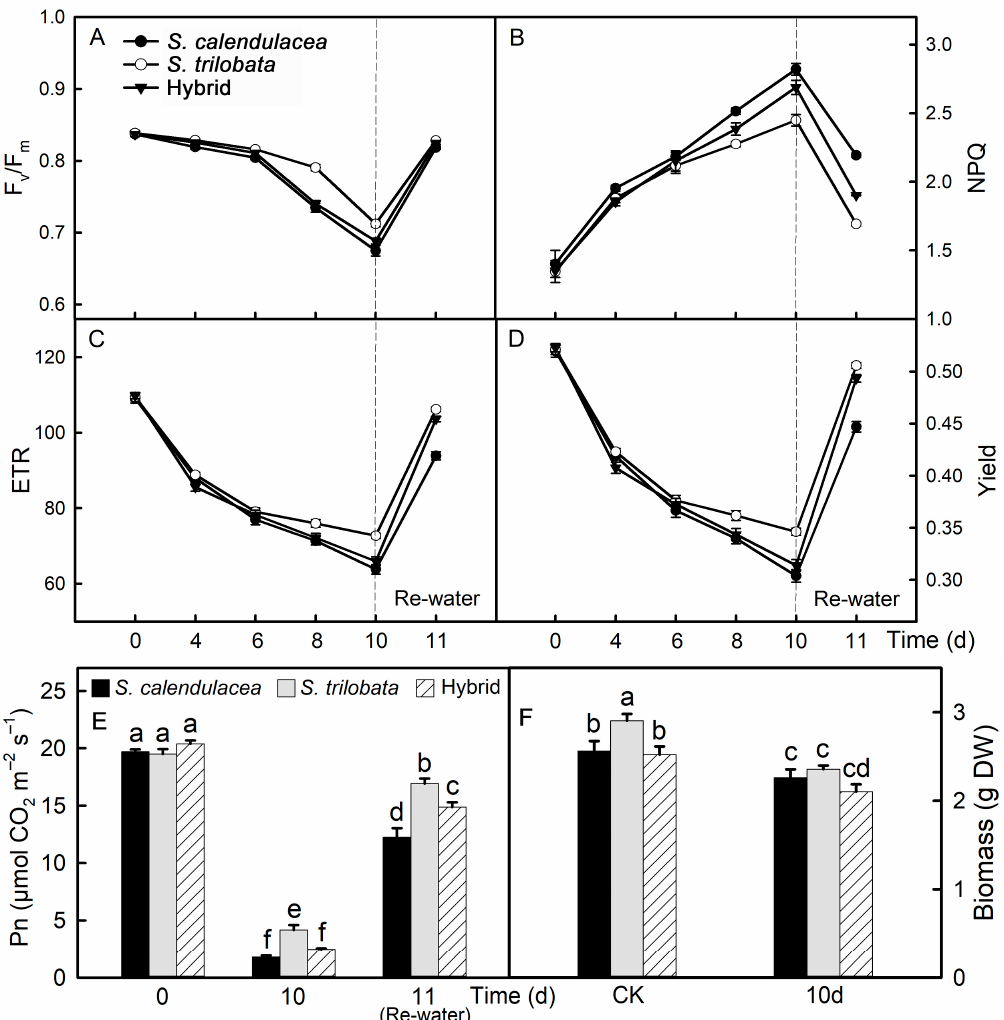
Figure 4. Chlorophyll fluorescence parameters and photosynthetic capacity. Changes of the maximum photochemical efficiency (F v /F m , A ), thermal dissipation (NPQ, B ), electron transport rate (ETR, C ), actual photochemical efficiency (yield, D ) and net photosynthetic rate (Pn, E ) in leaves of S . calendulacea , S . trilobata and their hybrid under drought stress and re-watered. Comparison of biomass ( F ) between control (CK) and drought for 10 days (10 d). Different lowercase letters (a, b, c, d, e, f) above bars indicate statistical significance ( p < 0.05).